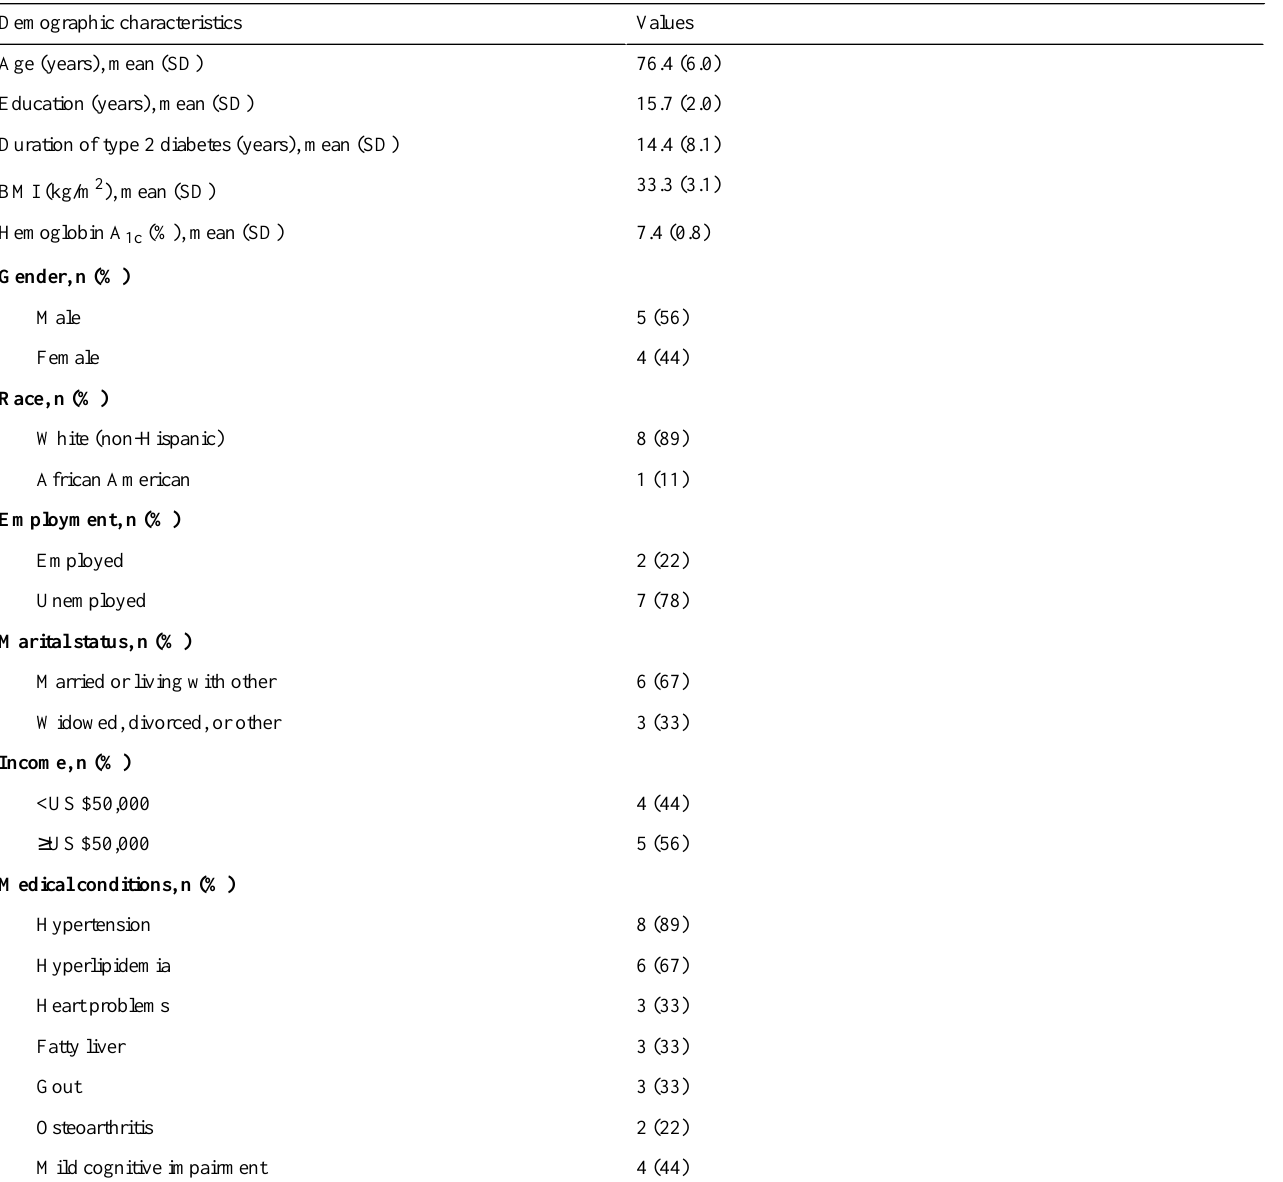
Table 1. Sample description (N=9).